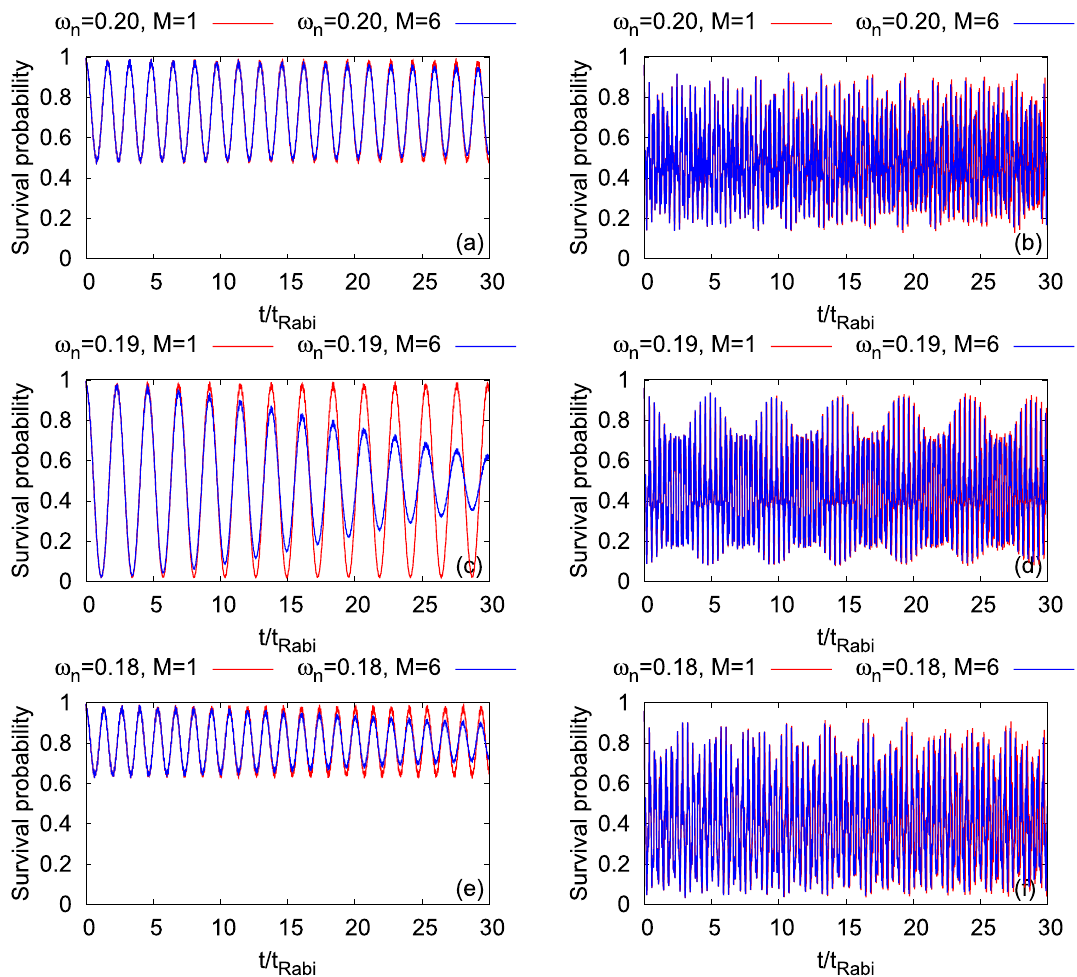
Figure 11. Dynamics of the survival probability of (cid:31) G (left column) and (cid:31) X (right column) in the left well of a transversely-asymmetric 2D double-well potential of N First, second, and third rows show the results at frequency, ω n signifies the mean-field results. The many-body dynamics are computed with M We show here dimensionless quantities. Color codes are explained in each panel.